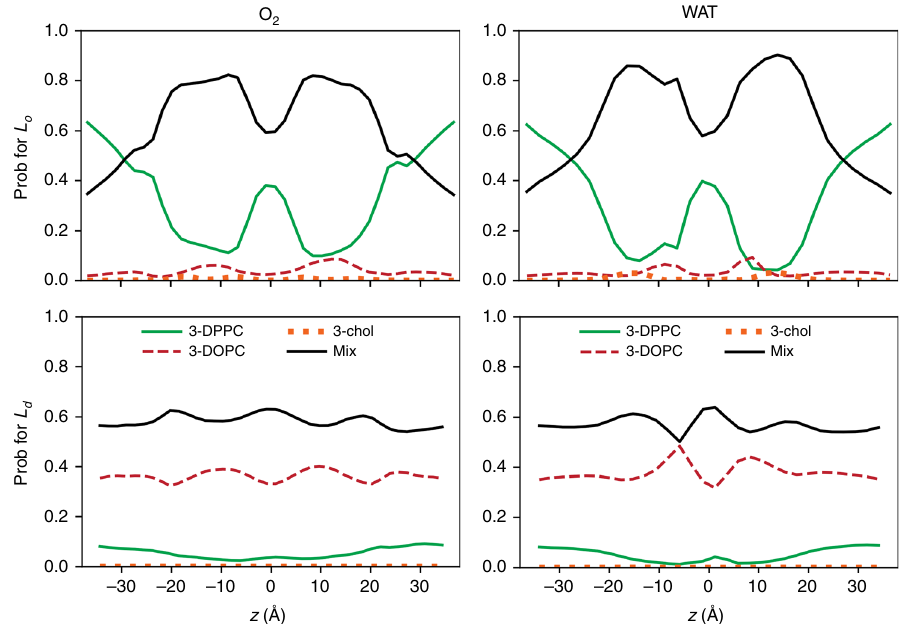
Fig. 4 Three nearest-neighbor analysis for permeation in DPPC/DOPC/chol. The probabilities of the classes of three nearest neighbors are shown for oxygen (left) and water (right) in the L o and L d phases. See the text for de fi nitions of the classes. Source data are provided as a Source Data fi